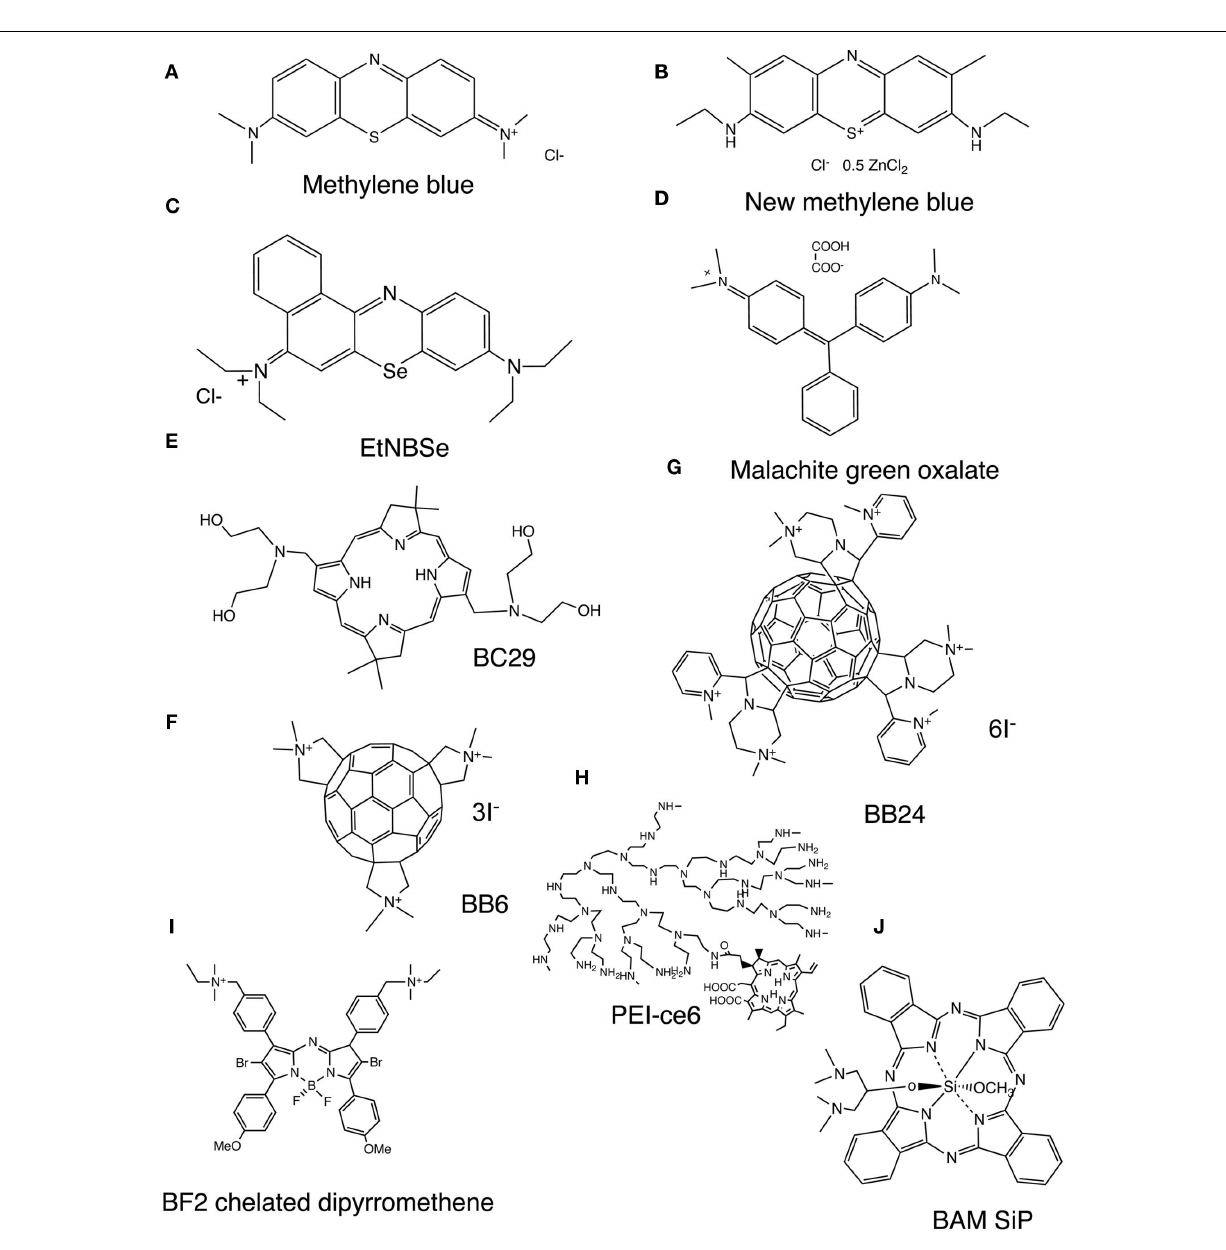
FIGURE 2 | Representative chemical structures of PS that have been reported to be especially active in the photoinactivation of fungal cells. (A) Methylene blue, MB, (B) , new methylene blue, NMB (Dai et al., 2011a); (C) , selenium Nile blue analog, EtNBSe (Foley et al., 2006); (D) , malachite green oxalate, (E) , bis -amino-substituted bacteriochlorin, BC29 (Huang et al., 2010a); (F) , tris - N -methyl-pyrrolidinium fullerene, BB6 (Tegos et al., 2005); (G) , hexakis-cationic fullerene BB24 (Huang et al., 2010b);